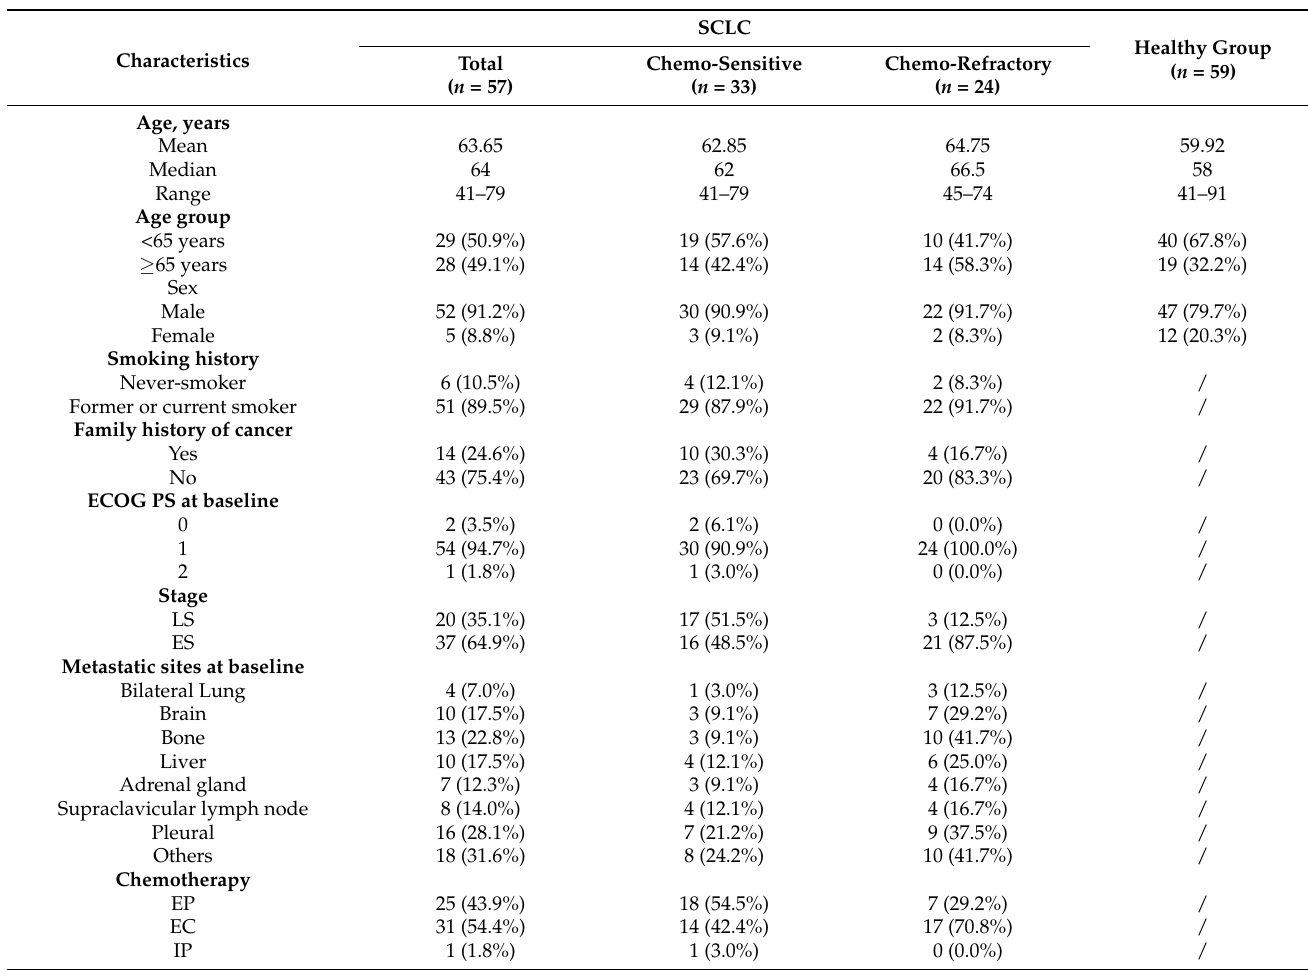
Table 1. Baseline